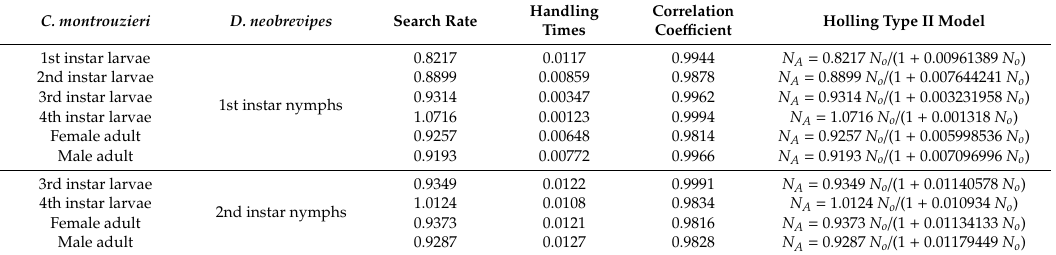
Table 3. Functional response parameters and Holling type II model of Cryptolaemus montrouzieri life stages to 1st and 2nd instar nymphs of Dysmicoccus